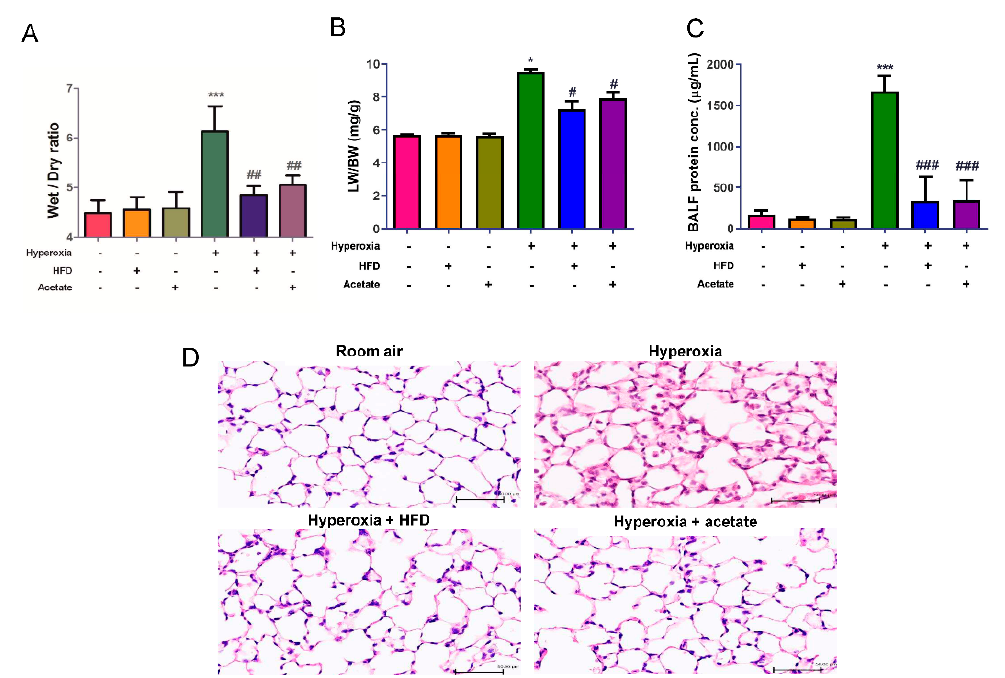
Figure 3. A high-fiber diet and acetate supplementation attenuate pulmonary edema and histopathological changes in mice exposed to hyperoxia. The lung W/D ( A ) and LW/BW ( B ) ratios, and the protein concentration in bronchoalveolar lavage fluid (BALF) ( C ) were significantly higher in the hyperoxia group. The high-fiber diet (HFD) and acetate supplementation significantly mitigated the hyperoxia-induced increases in these parameters. The HFD and acetate supplementation also significantly attenuated thickening of the alveolar walls and neutrophil infiltration in mice exposed to hyperoxia ( D ) (representative micrographs, scale bar = 50 μ m, hematoxylin and eosin staining). Data are mean ± SD (six mice per group). * p < 0.05, *** p < 0.001, compared with the ambient air group; # p < 0.05, ## p < 0.01, ### p < 0.001, compared with the hyperoxia group.